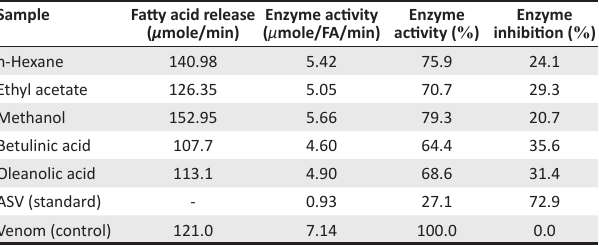
TABLE 1: Effect of extracts and betulinic and oleanolic acids on Naja nigricollis phospholipase-A activity. 2